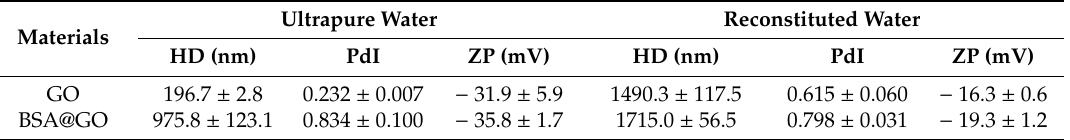
Table1. Hydrodynamicdiameter(HD),polydispersityindex(PdI),andzetapotential(ZP)measurements of GO and BSA@GO dispersions (10 mg L − 1 ) in ultrapure water and reconstituted water at 20 ◦